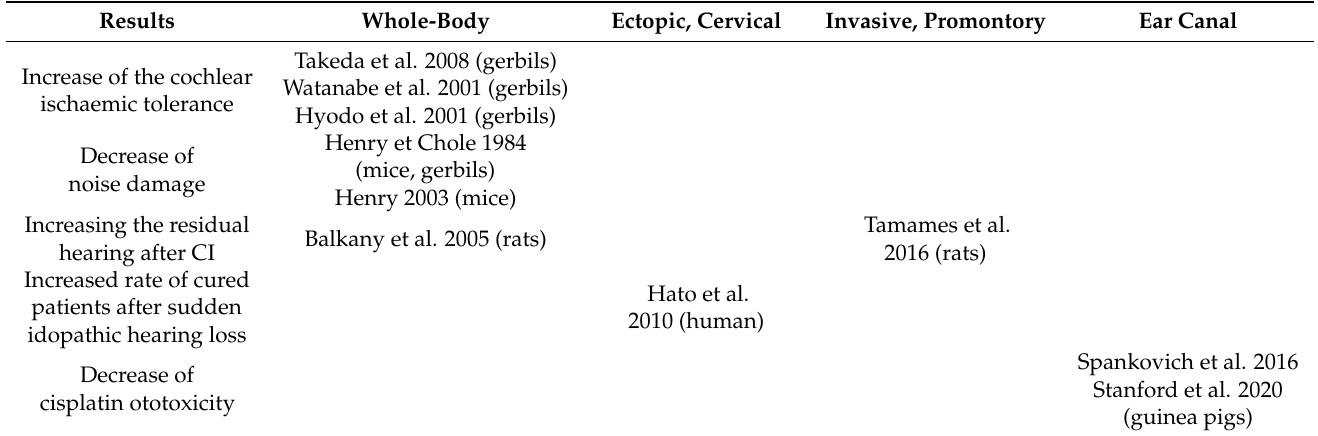
human patients. Table 1 summarizes the included papers, sorted by investigated effect and localization of cooling. Table 1. Study